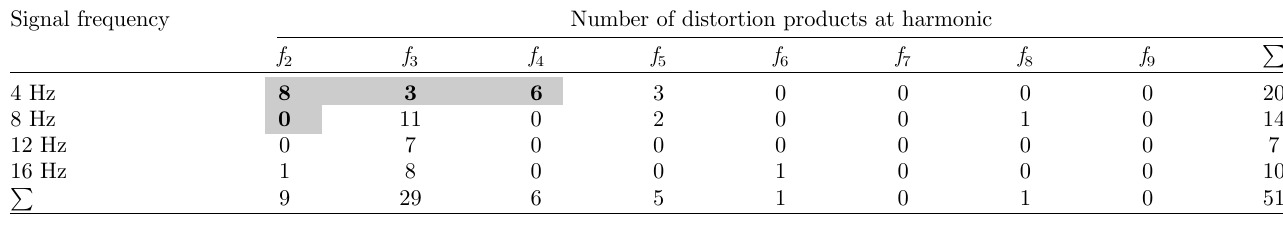
Table 2. Number of ear-generated distortion products found at the higher harmonics f 2 to f 9 of the signal frequency f 1 , based on 16 individual measurements of the magnitude spectrum per frequency. Harmonics in the infrasound range are indicated in bold